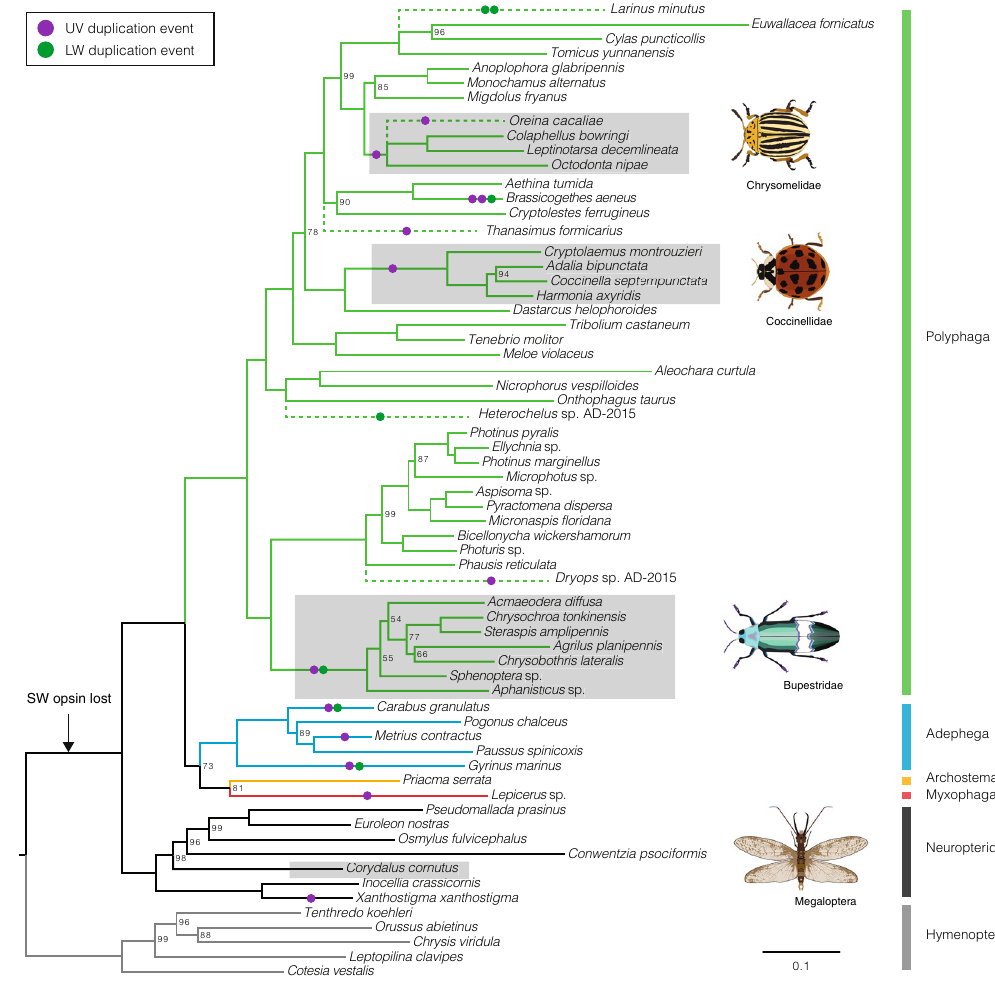
Figure 1. Opsin duplications within Coleoptera. Species phylogeny using 358 gene clusters from translated transcriptome assemblies, constructed using maximum likelihood. Node values indicate UFboot supports and only values < 100 are shown. Strepsipterans are not included due to poor support and placement of these species. For the full topology see Figure S2. Three major coleopteran UV opsin clades are highlighted in grey. Additional species with opsin duplications that were not included in the original species phylogeny are included at proposed positions (dashed lines). Solid circles denote putative UV (purple) and LW (green) duplications. The proposed timing of the SW opsin class loss is indicated (black